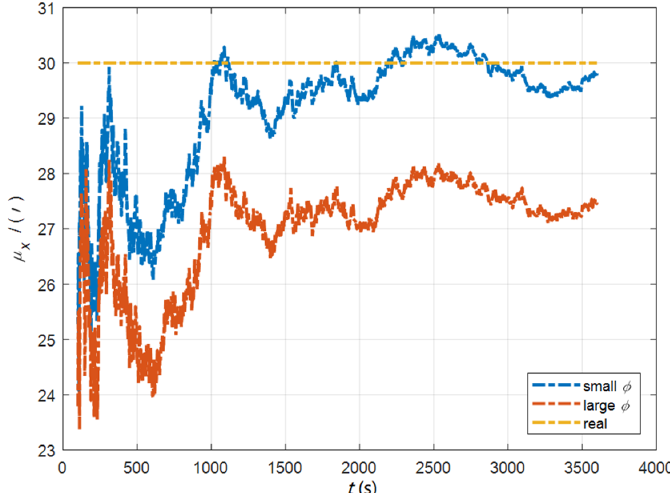
Figure 26. The curves of